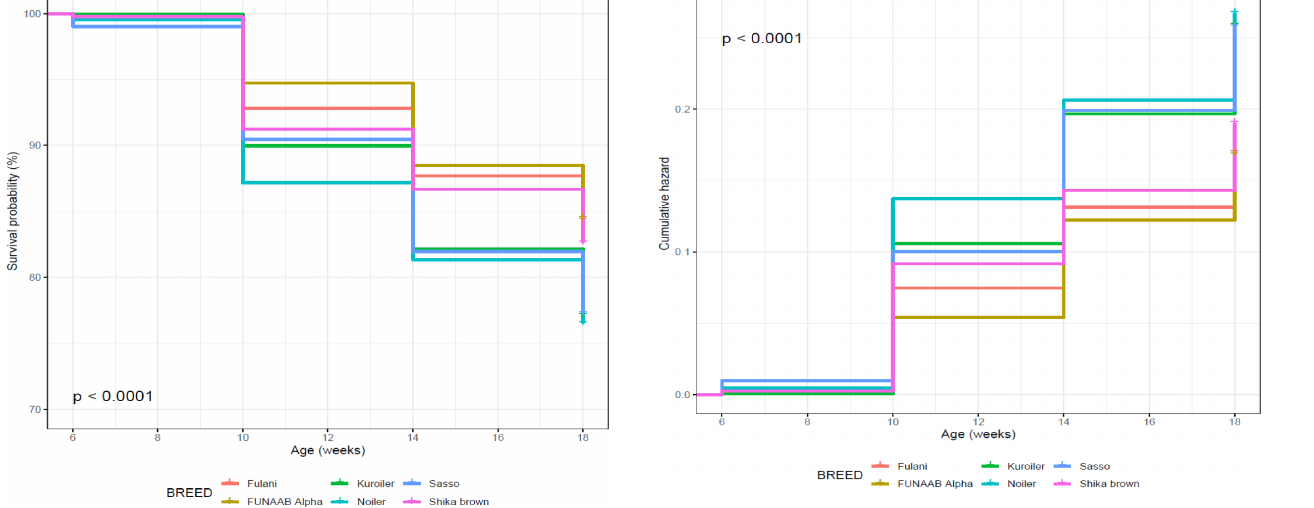
Figure 4. Effect of breed on overall on-farm survival performance of birds (male and female) during growing phase in ACGG Nigeria project zones (6–18 weeks) (2016–2017).